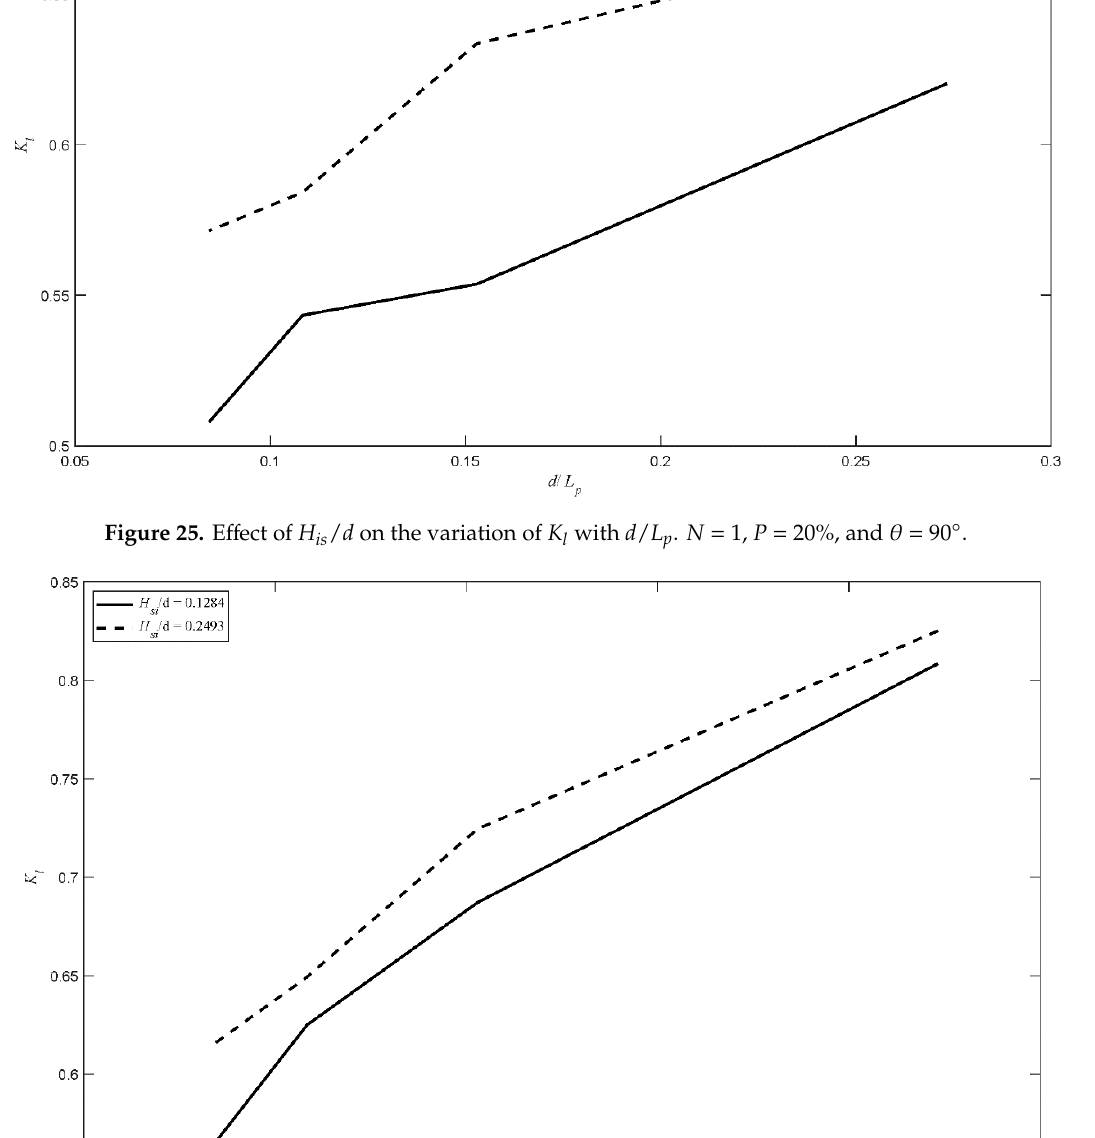
Figure 26. Effect of 𝐻 (cid:3036)(cid:3046) / 𝑑 on the variation of 𝐾 (cid:3039) with 𝑑 / 𝐿 (cid:3043) . N = 2, P = 20%, and θ = 90°. Figure 26. E ff ect of H is / d on the variation of K l with d / L p . N